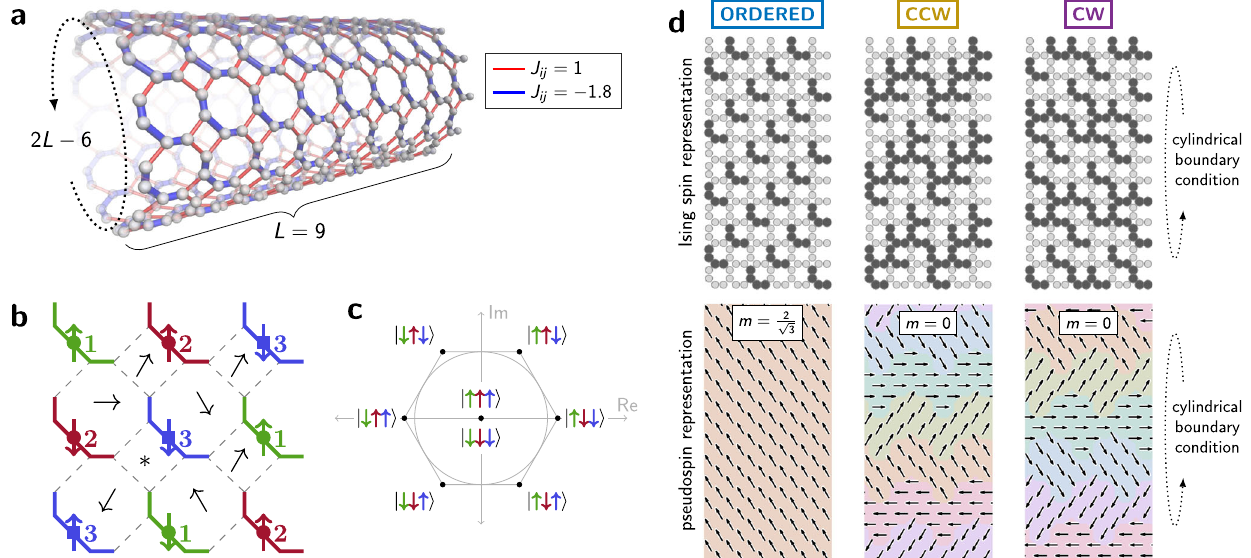
Fig. 1 Geometrically frustrated lattice and escape from topological obstructions. a We program the superconducting processor to simulate a lattice with cylindrical boundary conditions, with lattice width L ∈ {6, 9, 12, 15}. Each square or octagonal plaquette is frustrated, having an odd number of antiferromagnetic (red) couplers that cannot be satis fi ed simultaneously. b , c Each plaquette is composed of spins in three sublattices (indicated by green, red, blue) ( b ). Due to frustration, each plaquette has six ground states, which map to six orientations of a pseudospin based on the value of spins in the three incident sublattices ( c ). Adding quantum fl uctuations leads to ferromagnetic order in the pseudospins. d We initialize the simulation in three initial conditions: an ordered state, and states in which the pseudospin winds around the periodic dimension (top/bottom) counterclockwise (CCW) or clockwise (CW). Ordered states maximize the order parameter m , while CCW and CW have m = 0. Spin and pseudospin interpretations are shown. We simulate equilibration from these initial conditions using quantum (QA) and classical (PIMC)